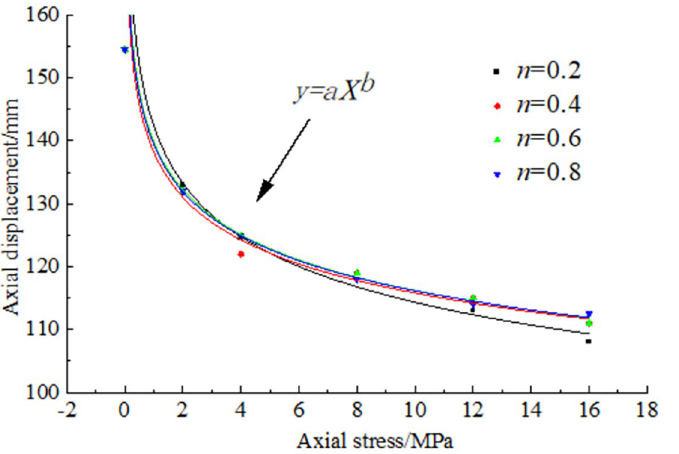
Fig 4. Relationship between the displacement and